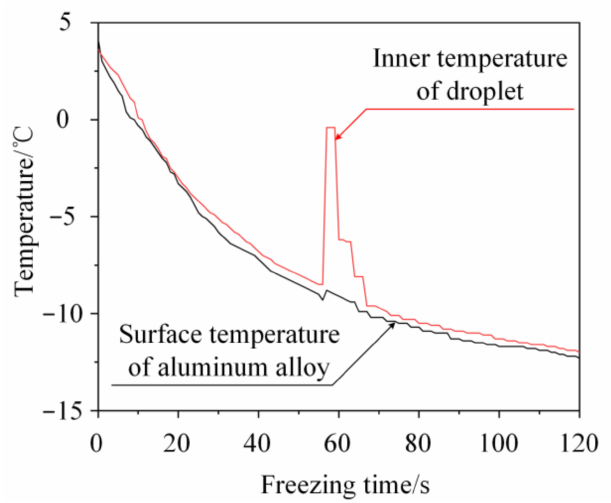
Figure 1. Inner temperature during the freezing process of a water droplet on an aluminum